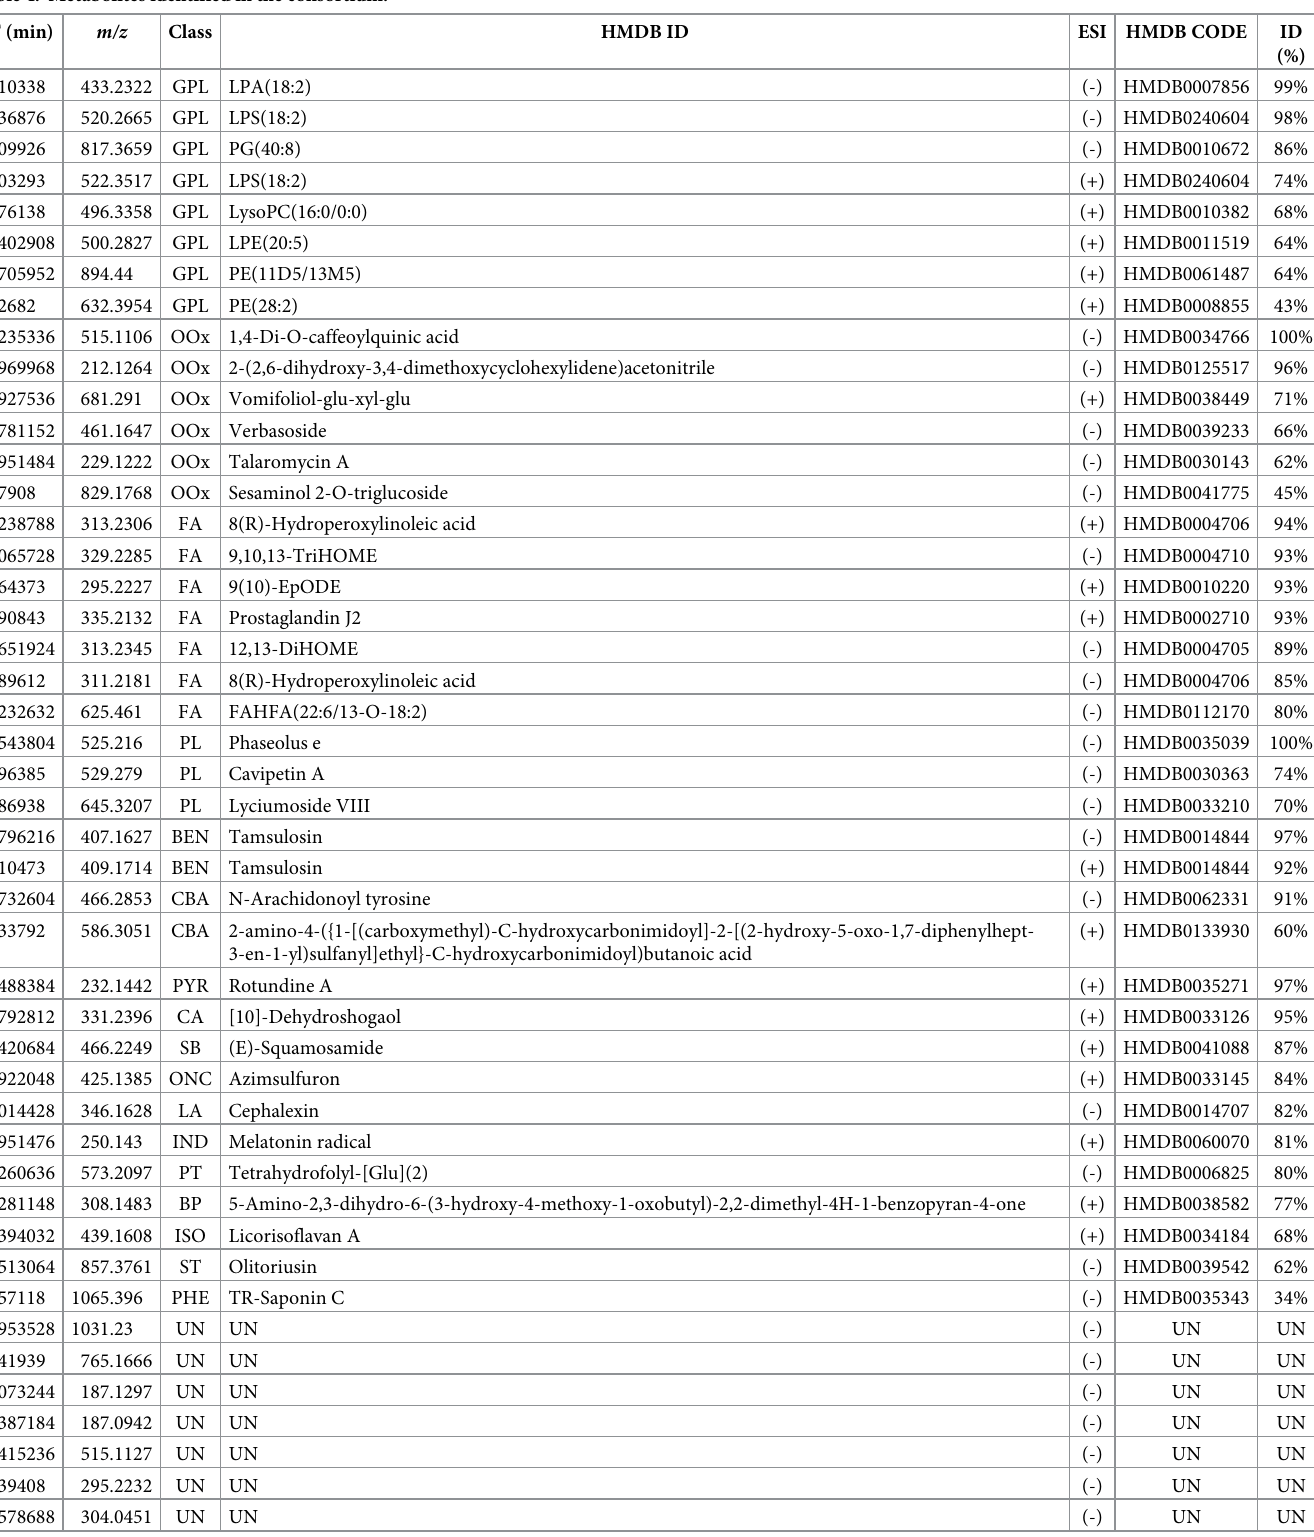
Table 4. Metabolites identified in the